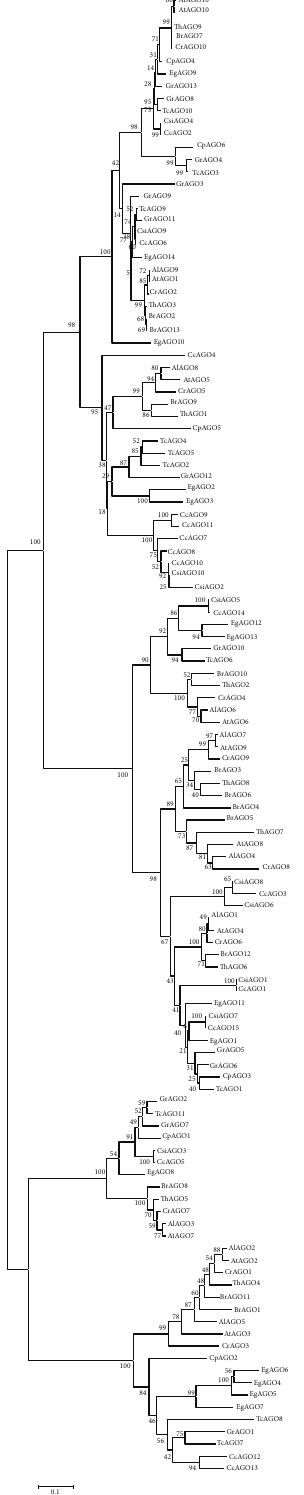
Figure 2: Phylogenetic tree of the Argonaute protein related to the Malvidae group which consists of A. thaliana, A. lyrata, Capsella rubella, Brassica rapa, Thellungiella halophila, Carica papaya, Gossypium raimondii, Theobroma cacao, Citrus sinensis, Citrus clementina, and Eucalyptus grandis AGO